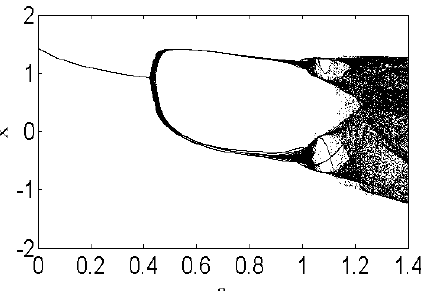
Figure 2. The bifurcation diagram of the fractional-order Henon map with x 0 = 0, y 0 = 0, α = 0.99 and b = 0.3.